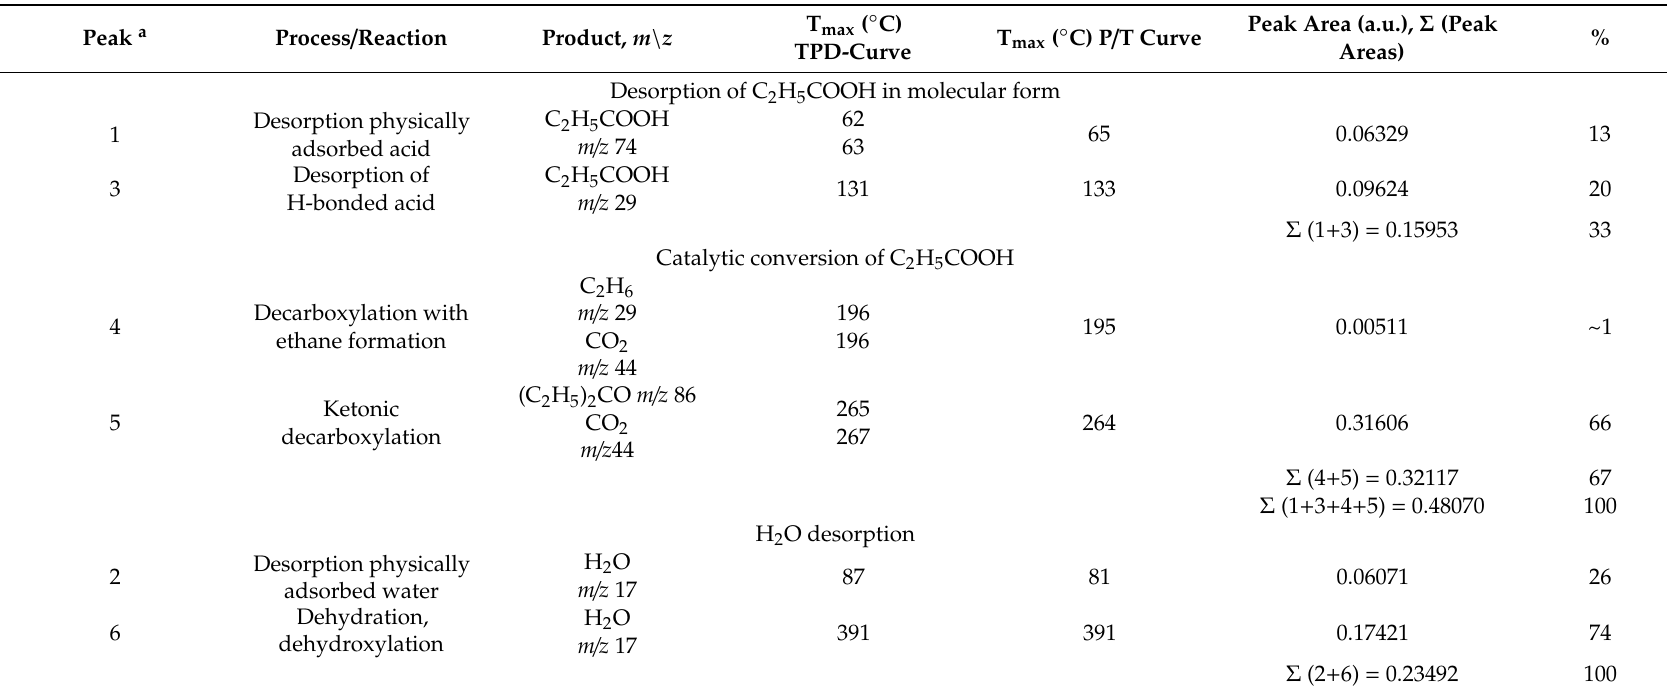
a Peak on the P / T curve (Figure